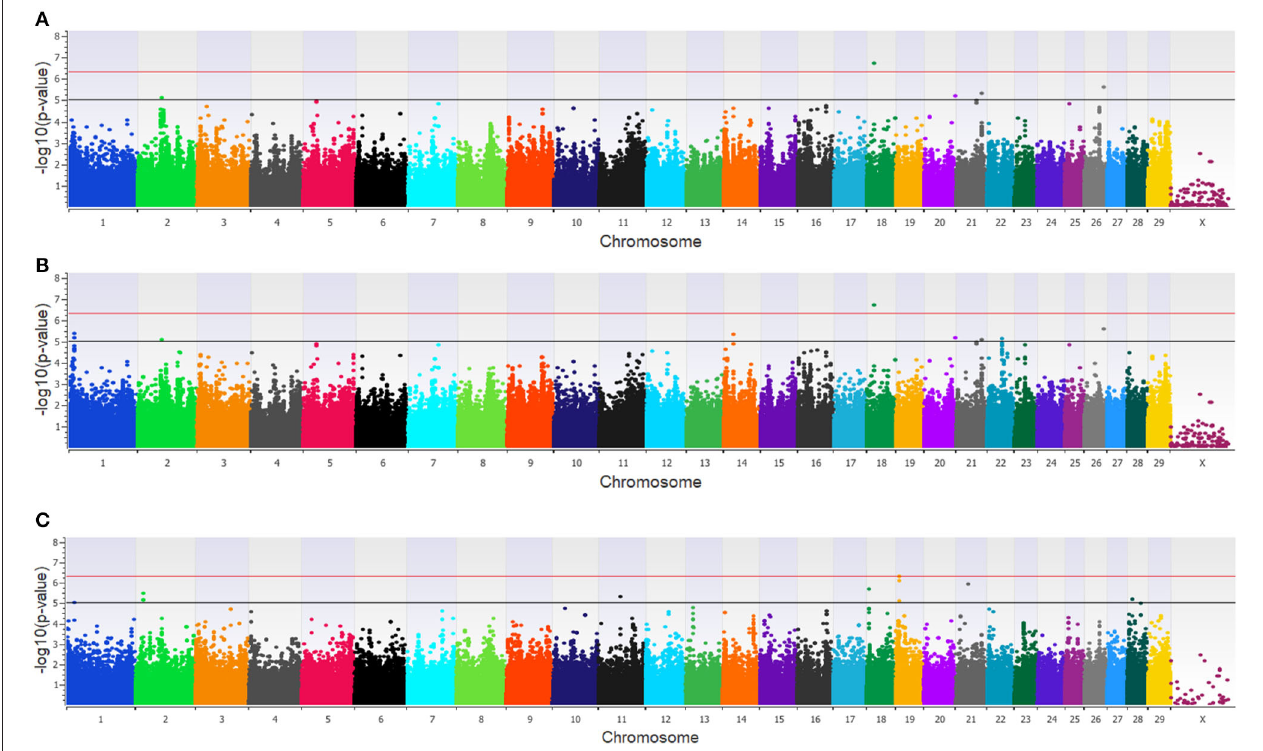
FIGURE 1 | Manhattan plots identifying loci associated with bovine coronavirus infection in additive (A) , dominant (B) , and recessive (C) EMMAX models for the dairy population. Single-nucleotide polymorphisms (SNP) are represented by a single dot. Bovine chromosomes are listed on the x-axis. SNPs located between the black and red line provide evidence of moderate association ( p between 1 × 10 − 5 and 5 × 10 − 7 ), and SNPs above the red line provide evidence of strong association ( p < 5 × 10 − 7 ) based on the Wellcome Trust Case Control Consortium (24)